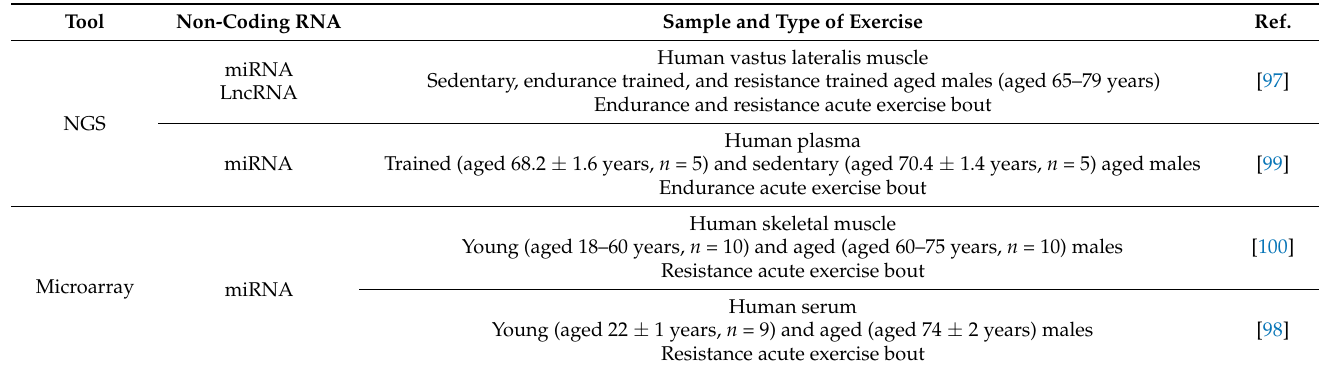
Table 2. Studies profiling expression of non-coding RNAs in sarcopenia after exercise. Tool Non-Coding RNA Sample and Type of Exercise